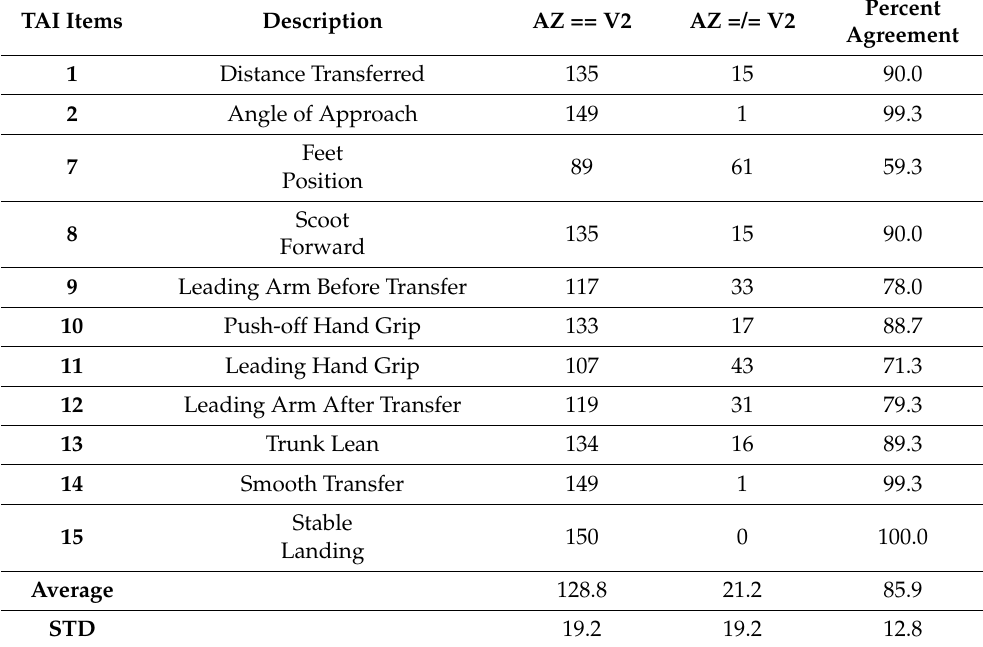
Table 7. Agreement between Azure and V2 ML outcomes from 150